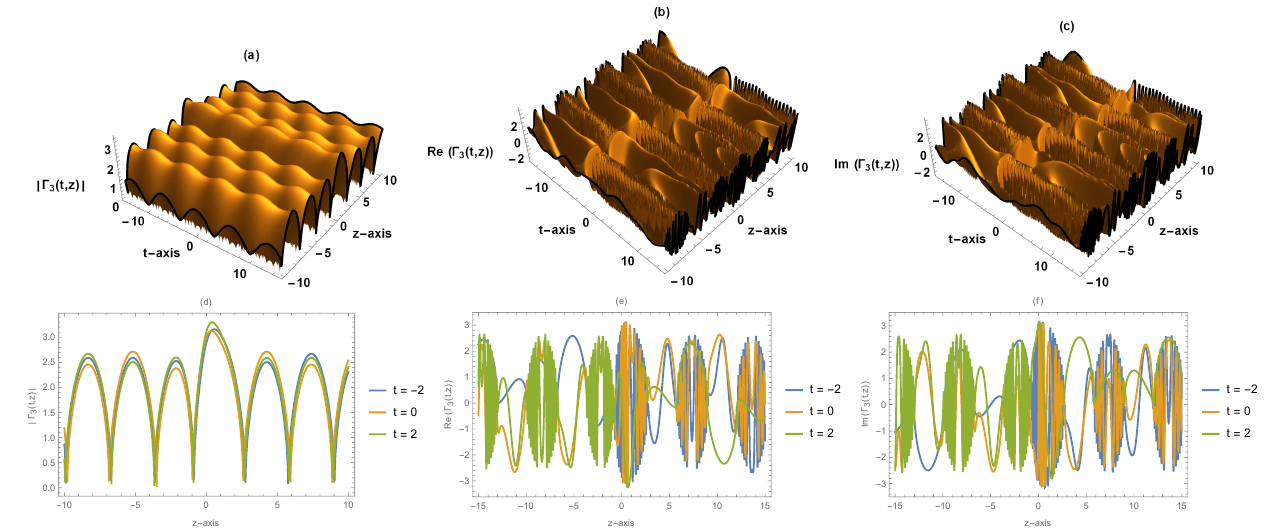
Figure 3. ( a , d ) Absolute value of Γ 3 ( t , z ) . ( b , e ) Real part of Γ 3 ( t , z ) . ( c , f ) Imaginary part of Γ ( t , z ) . The complex elliptic wave solution Γ ( t , z ) given by (24) in 3D and 2D plots for ρ 3 3 ρ 1 ( z ) = sin ( z ) , ρ 2 ( z ) = − 1/4, ¯ h 0 ( z ) = cos ( z ) , ¯ h 1 ( z ) = 1, q ( z ) = − 2sech 2 ( z ) , κ = − 1/2, θ = 1/5, (cid:61) = 1/5, b ( z ) = 0, b ( z ) = (cid:61) 2 , ∆ ( ξ ) = sn ( ξ ) 3 4